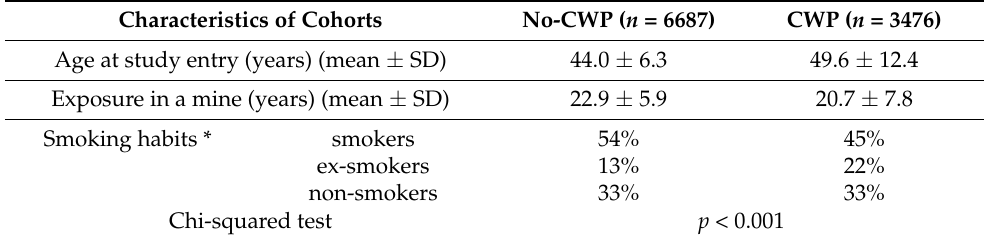
Table 1. Description of the groups of miners without/with coal-workers’ pneumoconiosis. Characteristics of